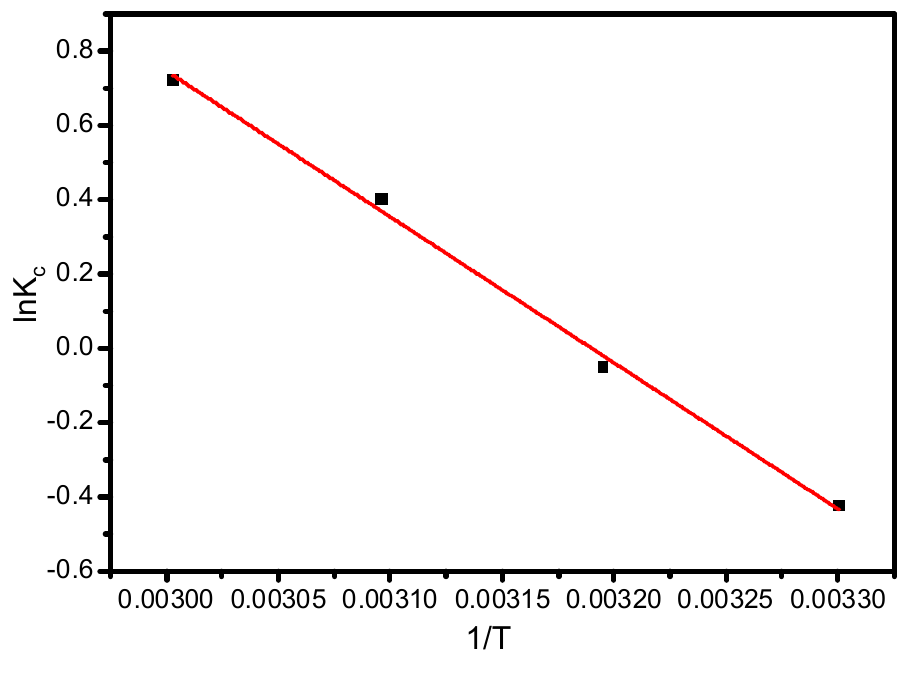
Figure 9. Thermodynamic plot for ln Kc vs. 1/T for the estimation of enthalpy and entropy of ad- sorption reaction of Pb (II) and XGFO